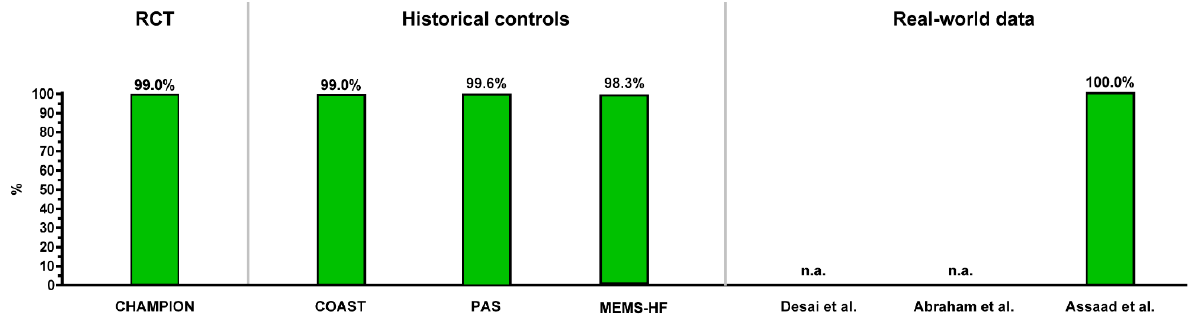
Figure 8. Overview of the safety (freedom of device- or system-related complications at 12 months) of the CardioMEMS HF system as reported in clinical studies.